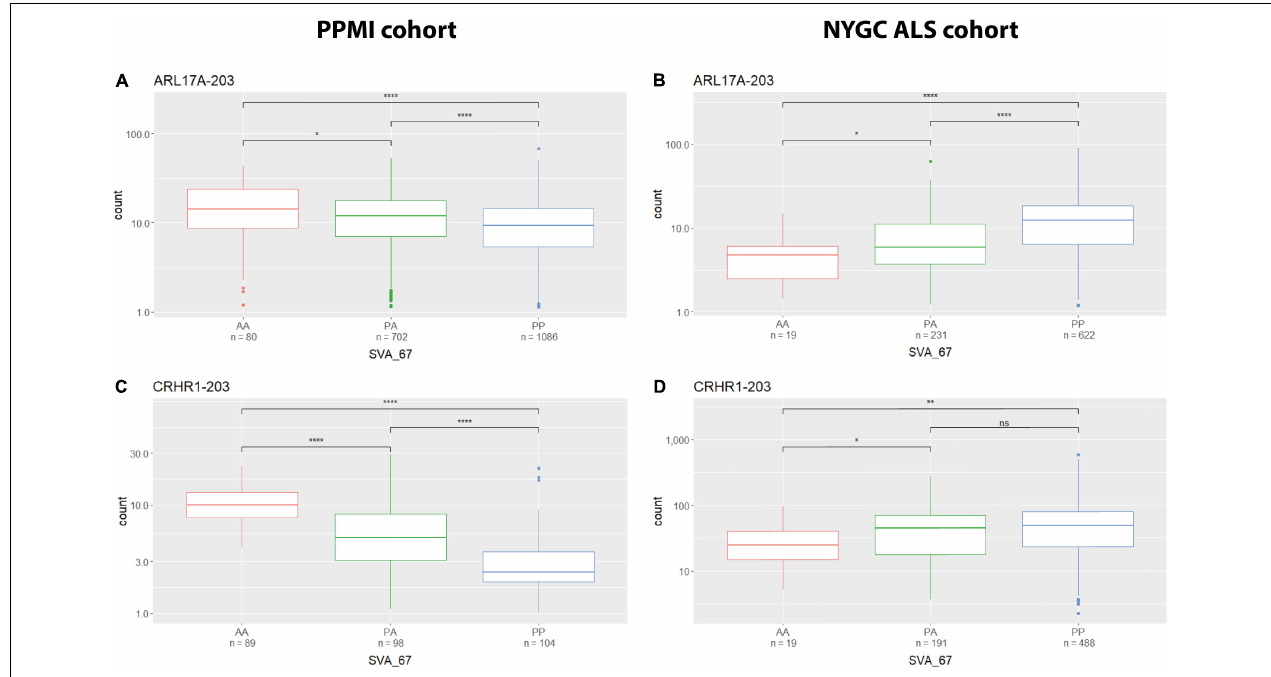
FIGURE 4 | Tissue specific influence of SVA_67 genotype. Using the PPMI cohort, isoforms ARL17A-203 (A) and CRHR1-203 (C) show significantly reduced expression with PP genotype, while the opposite effect is observed when using the NYGC ALS cohort (B,D) . Wilcoxon test was applied to demonstrate statistical significance indicated as asterisks. * P ≤ 0.05, ** P ≤ 0.01, *** P ≤ 0.001, **** P ≤ 0.0001, ns >